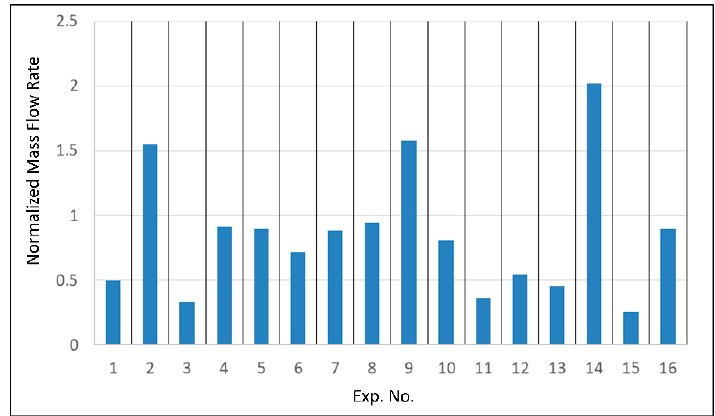
Figure 12. Normalized leakage rate of experiments (screening experiments).